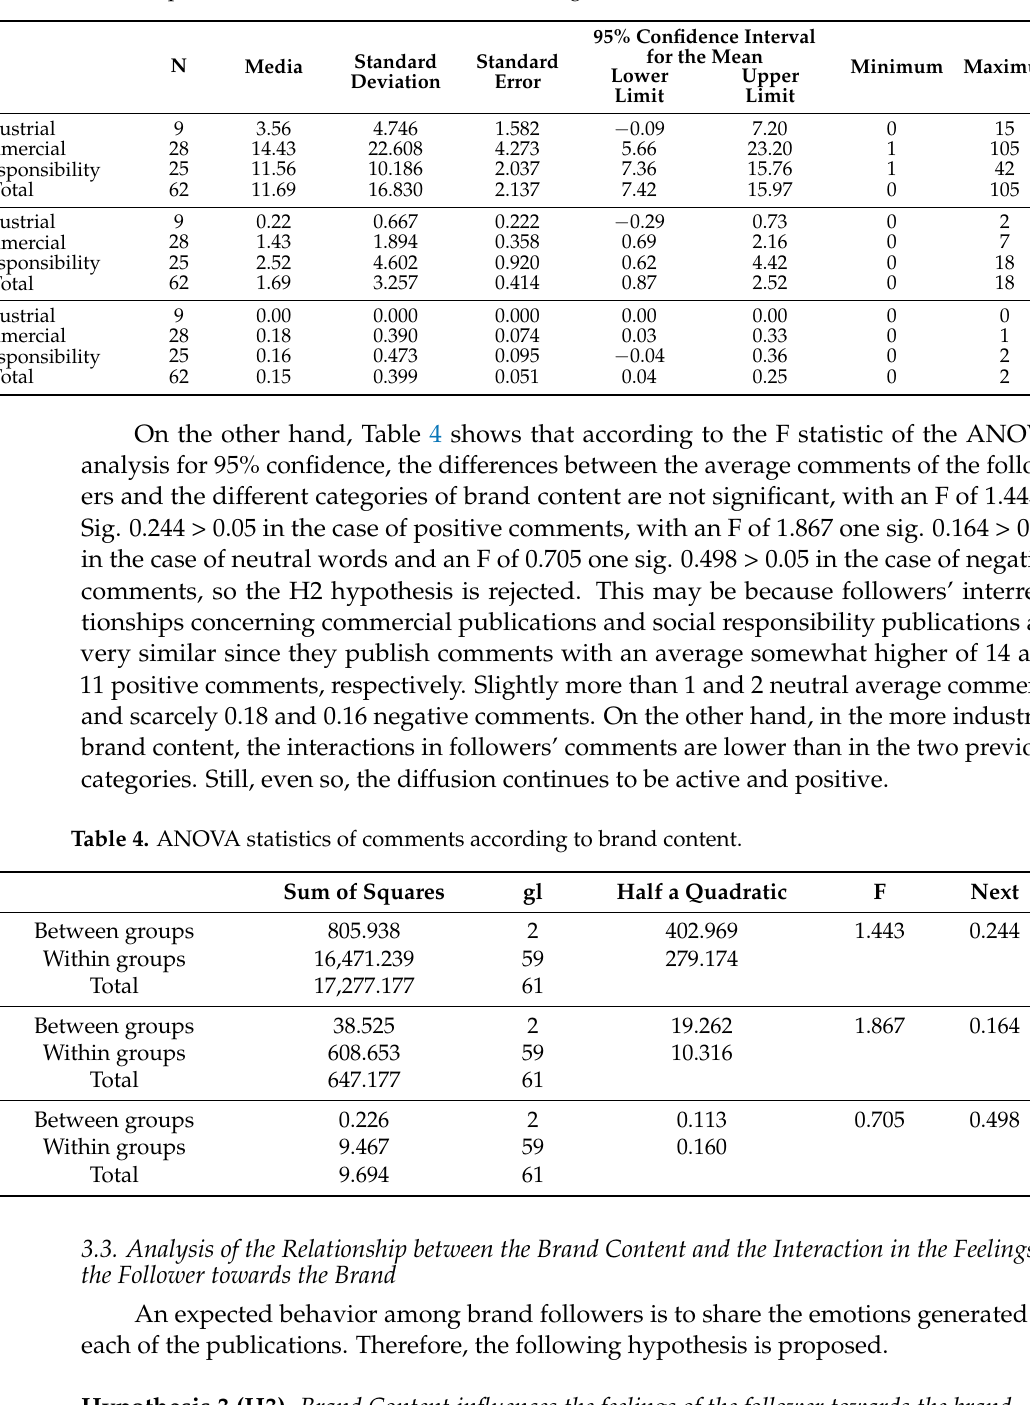
Table 3. Descriptive statistics of the comments according to the brand content.